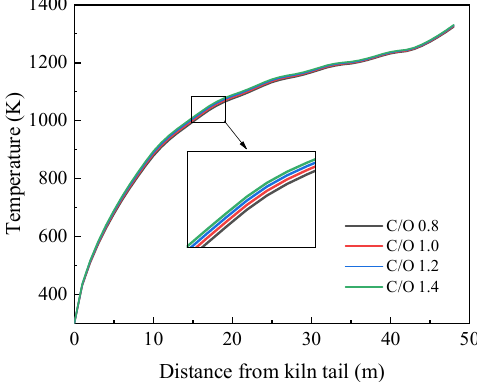
Figure 11. Average bed temperature along the axial section for different C/O mole ratios.